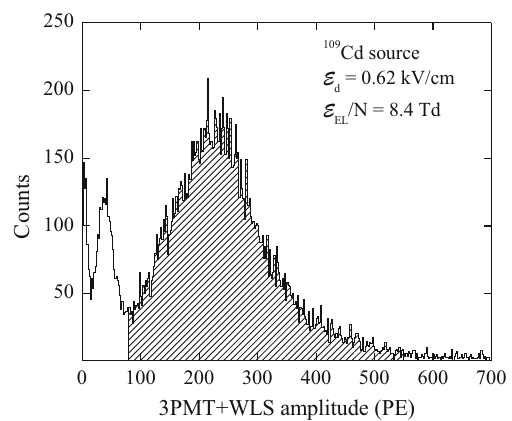
Fig. 10 Direct SiPM-matrix readout: amplitude spectrum of the total 3PMT + WLS signal obtained with 109 Cd source for the maximum field in the EL gap. The higher energy peak, corresponding to 59–88 keV gamma-rays, is hatched